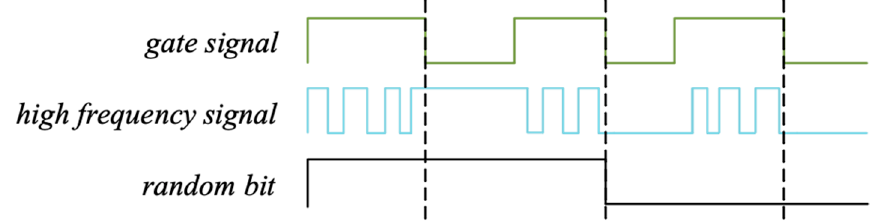
Figure 13. 1-bit random number generator working principle diagram.